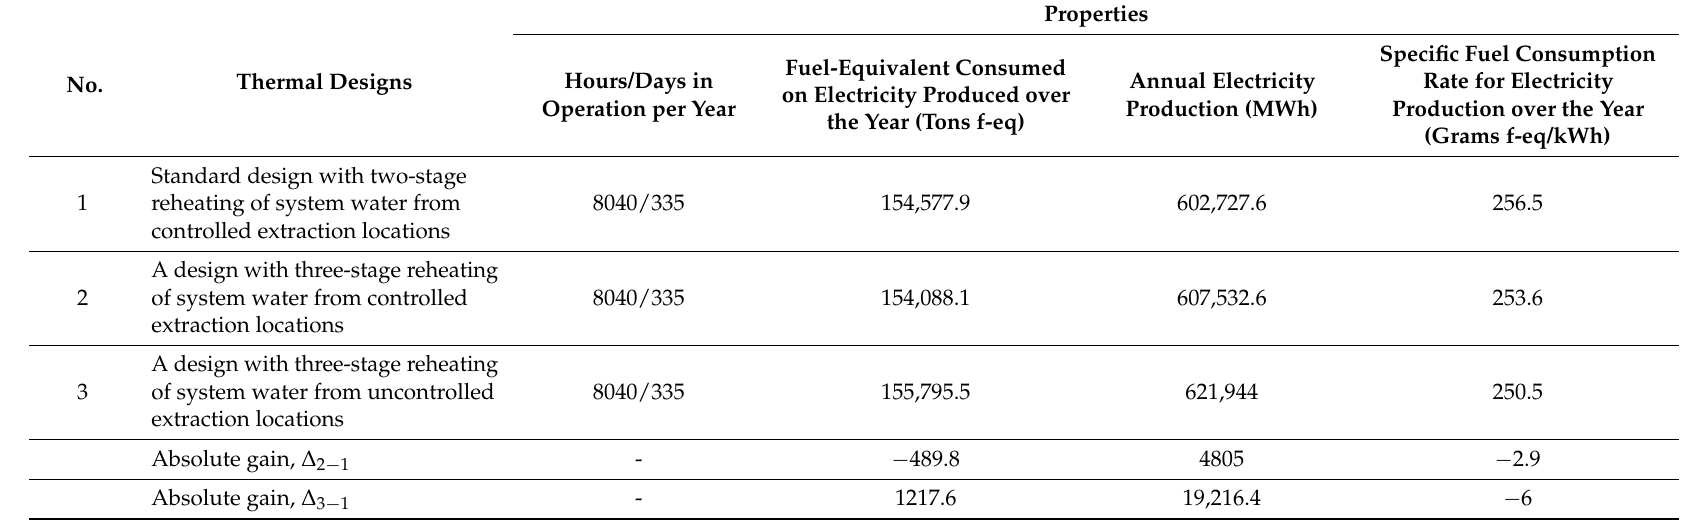
Table 3. Year-round efficiency of turbine unit thermal designs (boiler unit unloaded to the process minimum (60%) in the